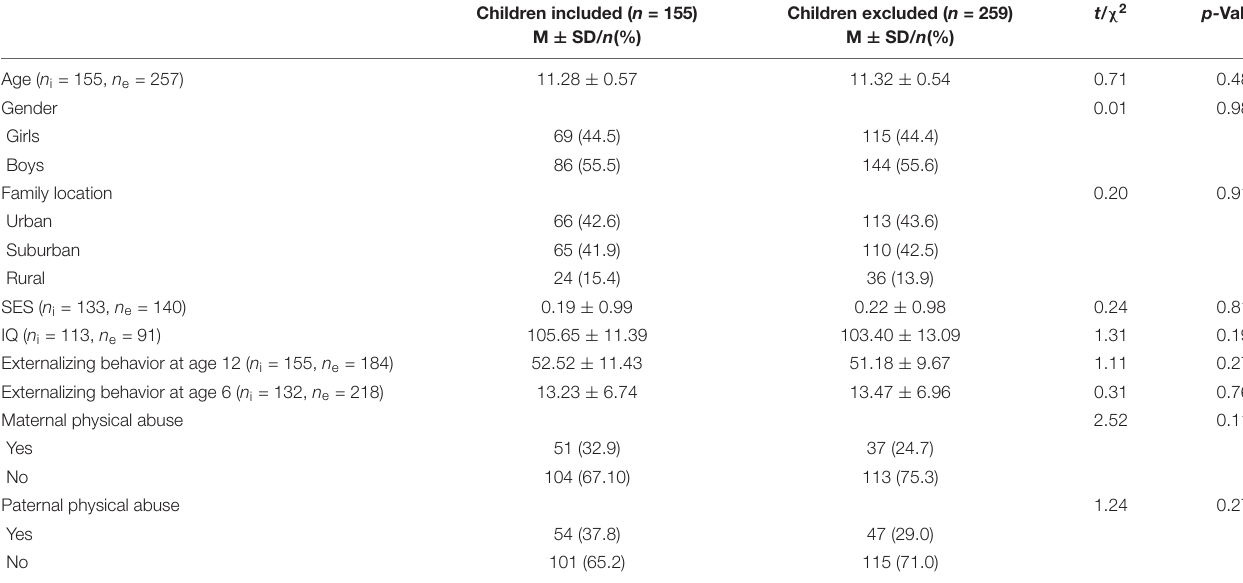
TABLE 1 | Sociodemographic characteristics of the present sample and comparisons with the children not included in the present study.